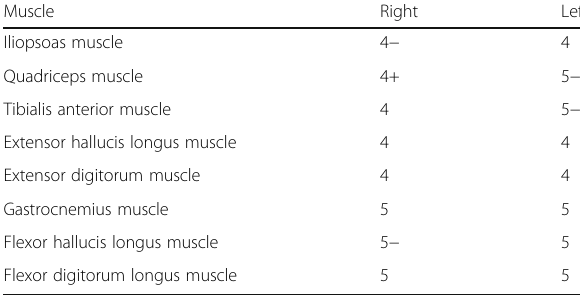
Table 1 Results of manual muscle testing